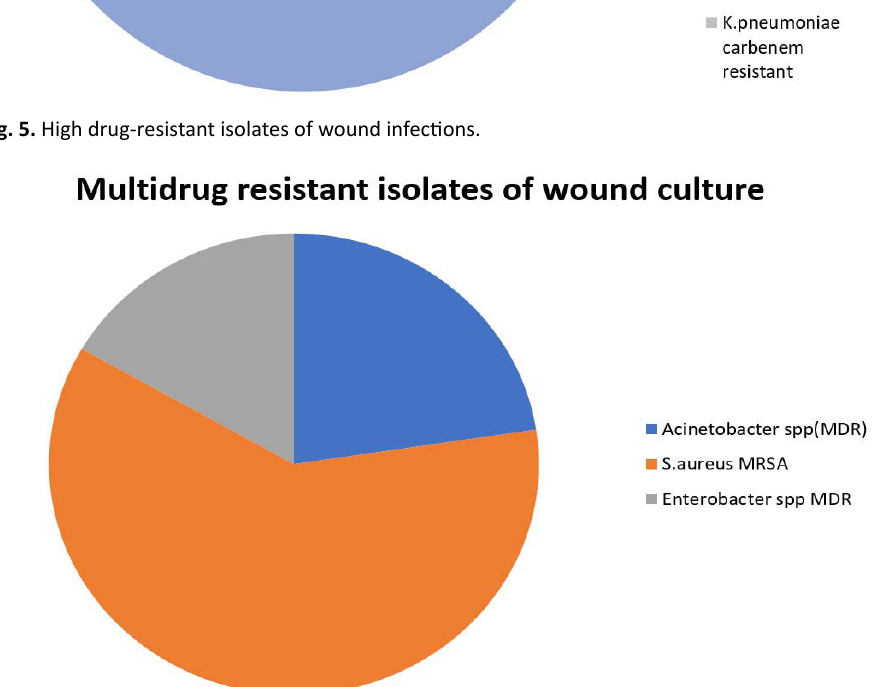
Fig. 6. Multidrug resistant isolates of wound